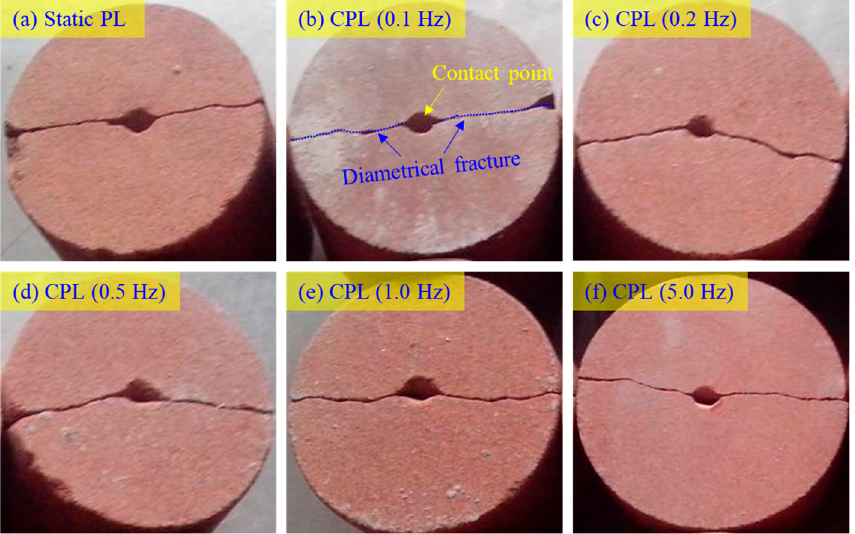
Figure 5. Failure pa tt ern of YNS subjected to ( a ) monotonous point loading and ( b – f ) CPLs with di ff erent